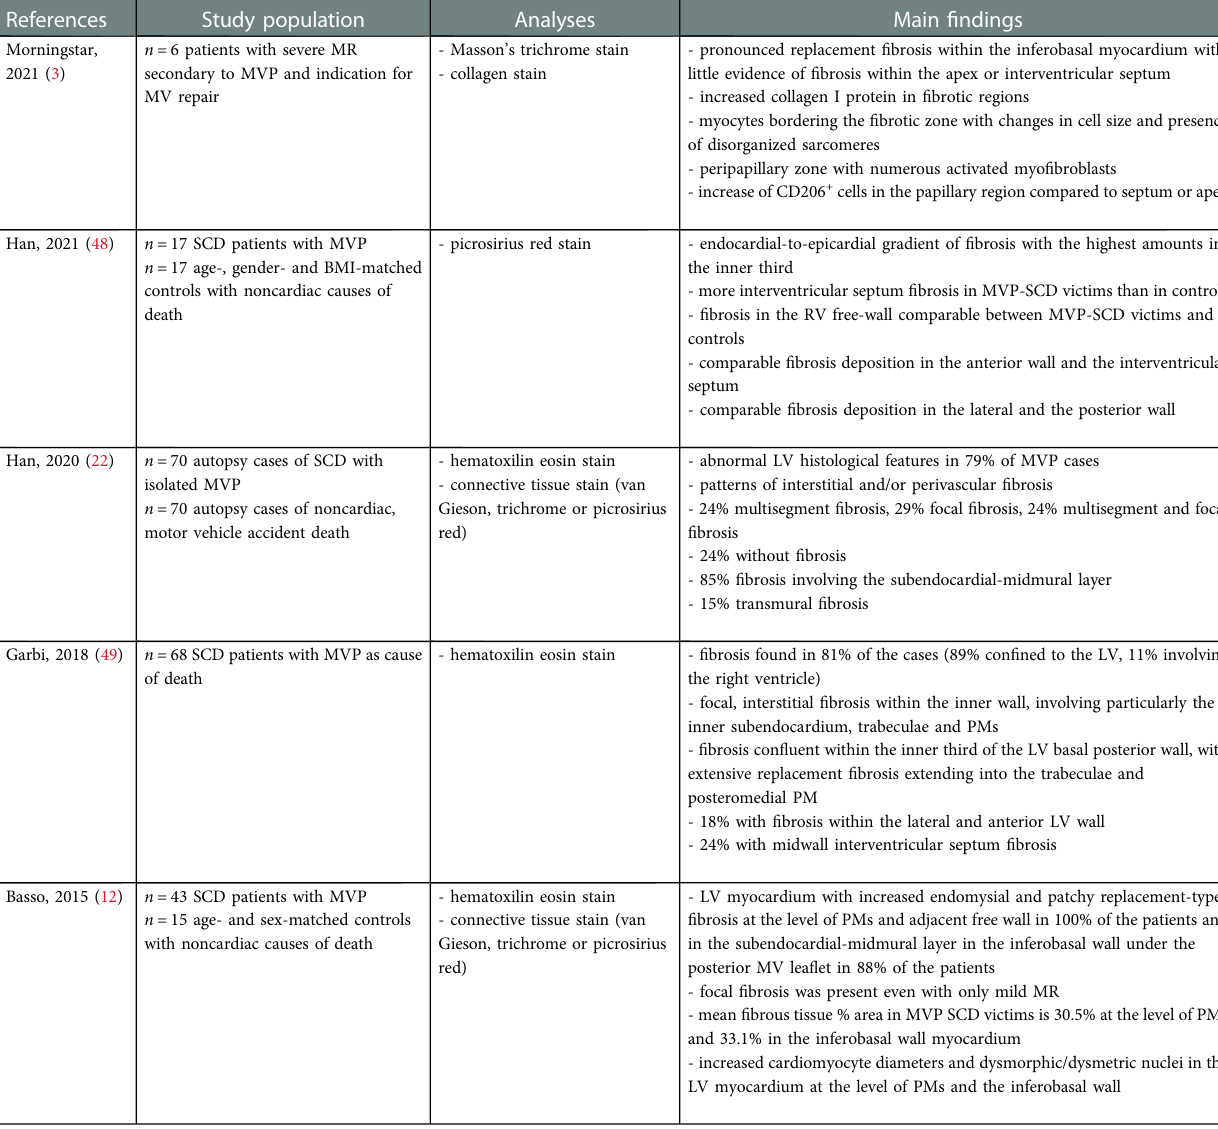
TABLE 1 Overview of studies investigating myocardial fi brosis in MVP